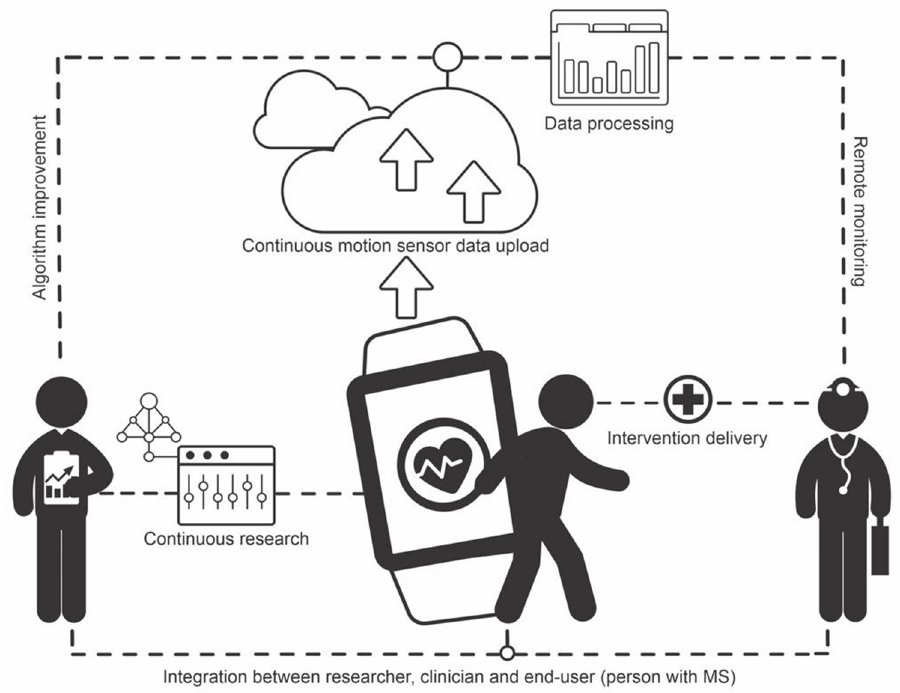
Figure 3. Illustration of the structure of a smart system for integration of researchers, clinicians, and people with multiple sclerosis. End-user motion sensor data are continuously uploaded to the cloud and processed via algorithms embedded in the cloud. Researchers use the data for algorithm improvement. Clinicians monitor patients remotely and deliver interventions as needed.